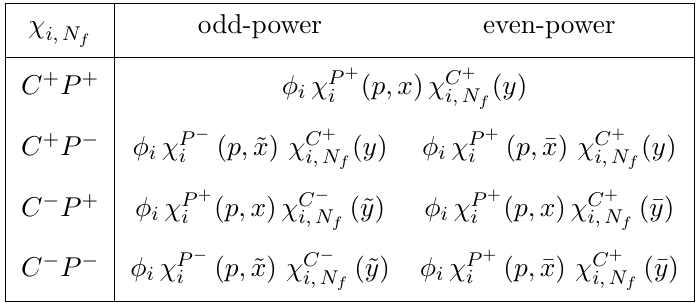
Table 4 . Single particle module characters χ C,P branch element characters χ P ±